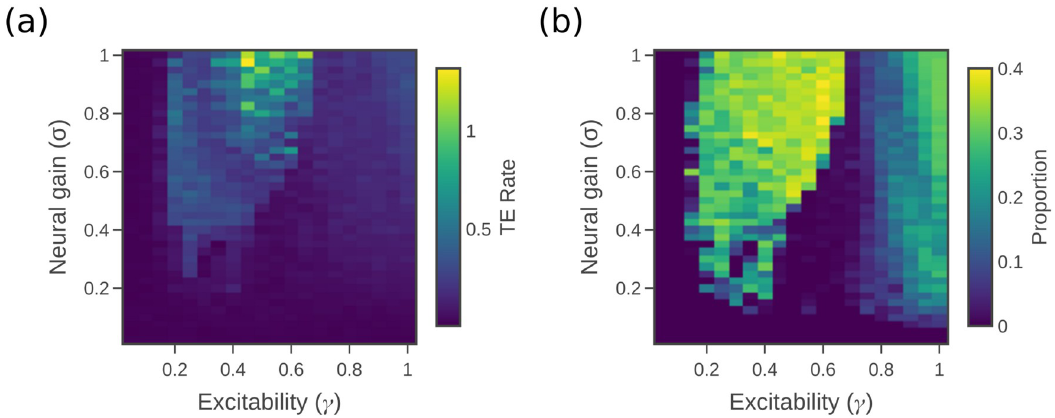
Fig 5. Information transfer between hemispheres. (a) TE rate over interhemisphere causal edges. (b) Proportion of significant TE rate measurements occuring between interhemisphere source and target.